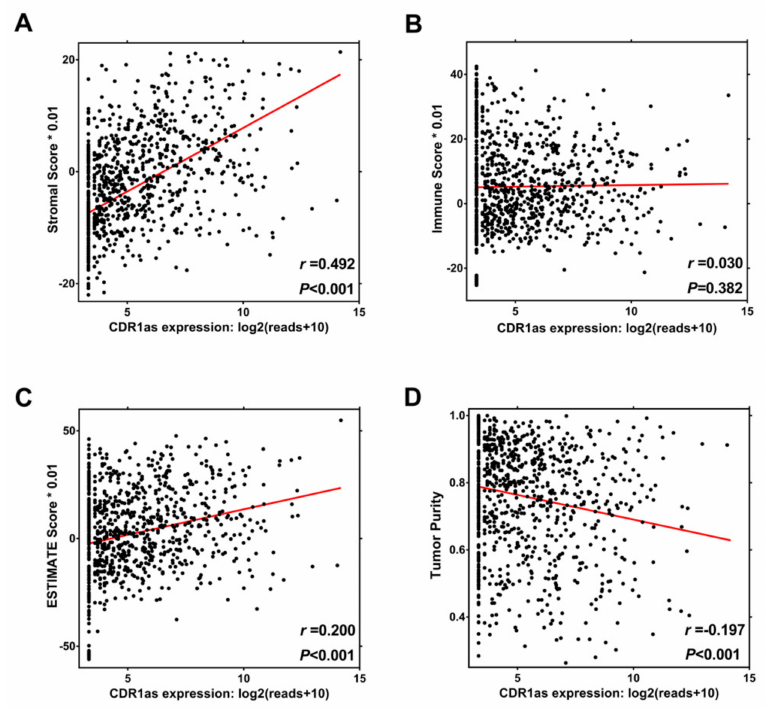
Figure 5. Relationship between CDR1as expression and tumor microenvironment evaluated by ESTIMATE algorithm. Correlation of CDR1as expression with ( A ) Stromal score, ( B ) Immune score, ( C ) ESTIMATE score and ( D ) Tumor